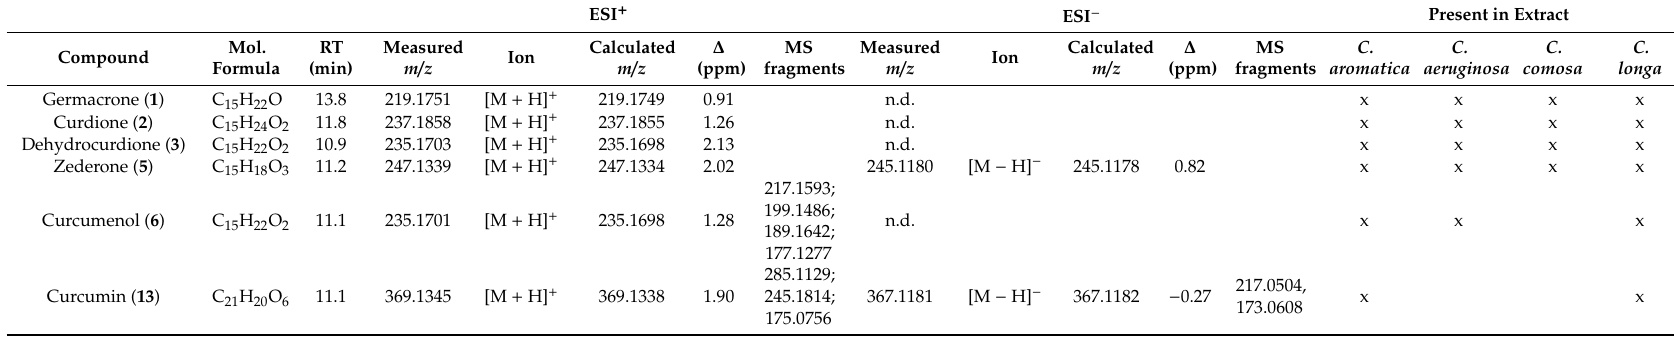
Table 1. Chromatographic and spectral data, obtained with Ultra-Performance Liquid Chromatography–High Resolution Mass Spectrometry (UPLC-HRMS)analysis. ESI + ESI − Present in Extract ∆ Mol. RT Measured Calculated MS Measured Calculated Compound Ion Ion m / z m / z m / z m / Formula (min) (ppm) fragments